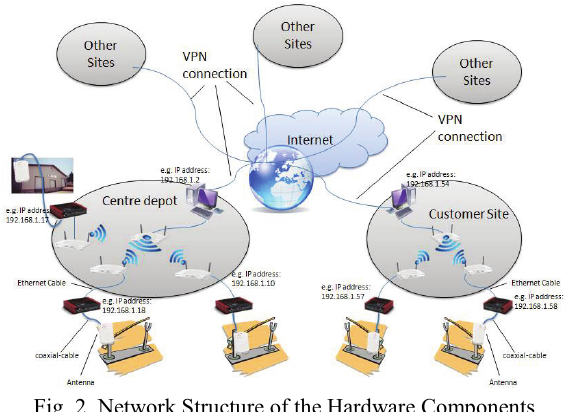
Fig. 2. Network Structure of the Hardware Components